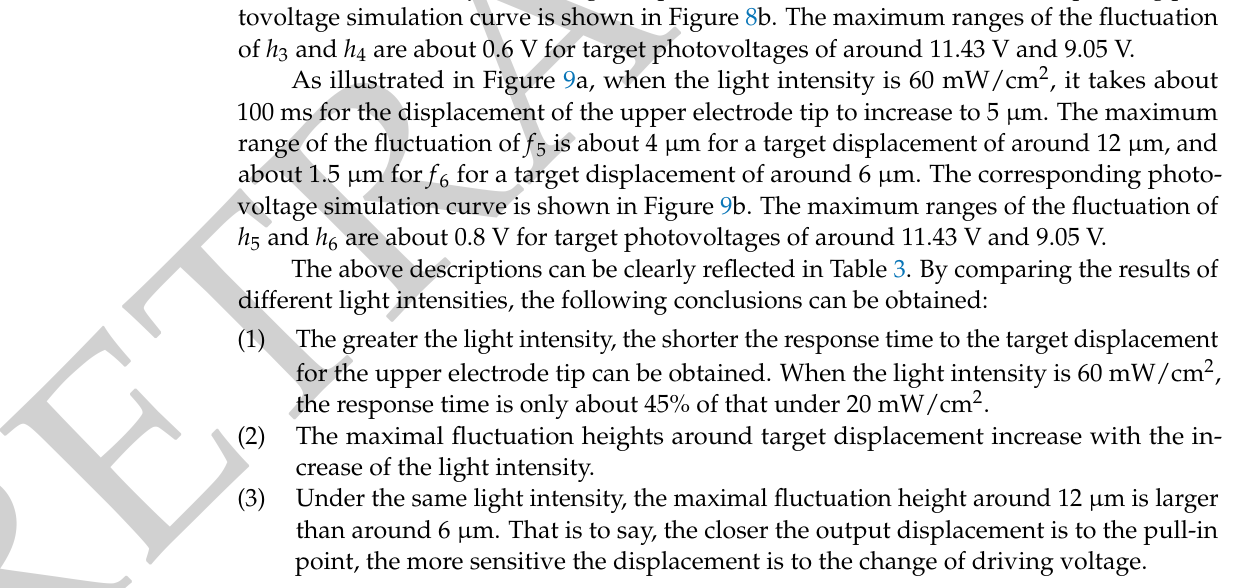
Table 3. The driving performance of photovoltaic-electrostatic hybrid actuator.